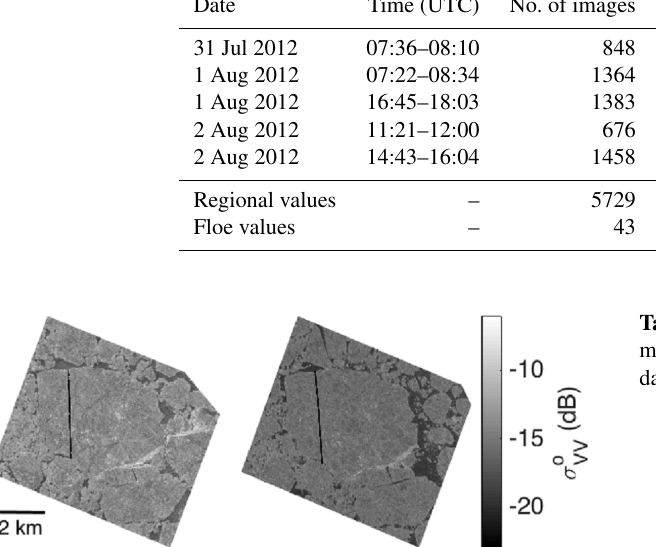
Figure 2. The floe investigated in scene T3 (left) and T4 (right) with an 11 × 11 pixel smoothing window. The black line marks the transect along which the helicopter image were taken.